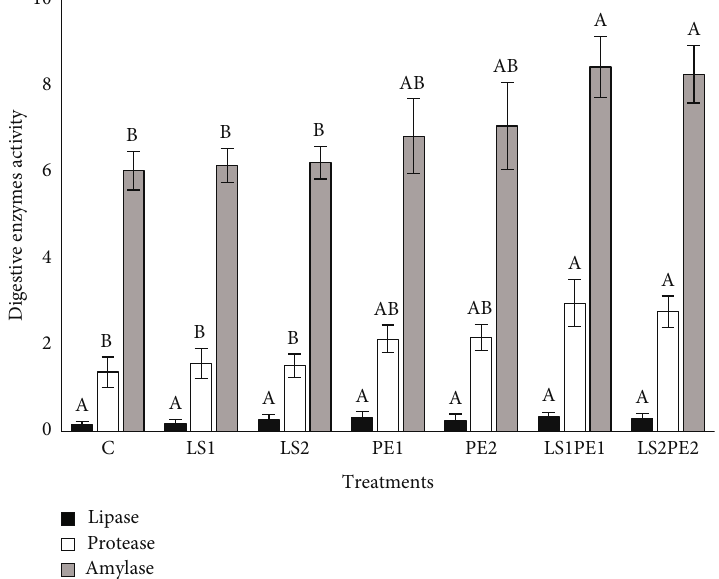
Figure 1: Digestive enzymes activity including lipase, protease, and amylase narrow-clawed cray fi sh ( P. leptodactylus ) fed with basal diet and supplemented with LS1 ( L. salivarius , 1 × 10 7 CFU/g), LS2 ( L. salivarius , 1 × 10 9 CFU/g), PE1 (Pectin, 5g/kg), and PE2 (Pectin, 10g/ kg), LS1PE1 ( L. salivarius , 1 × 10 7 CFU/g+ Pectin, 5g/kg), and LS2PE2 ( L. salivarius , 1 × 10 9 CFU/g+ Pectin, 10g/kg) for 18 weeks. Bars represent the mean ± SD ( n = 3 ). Di ff erent superscripts show signi fi cant di ff erences between the experimental